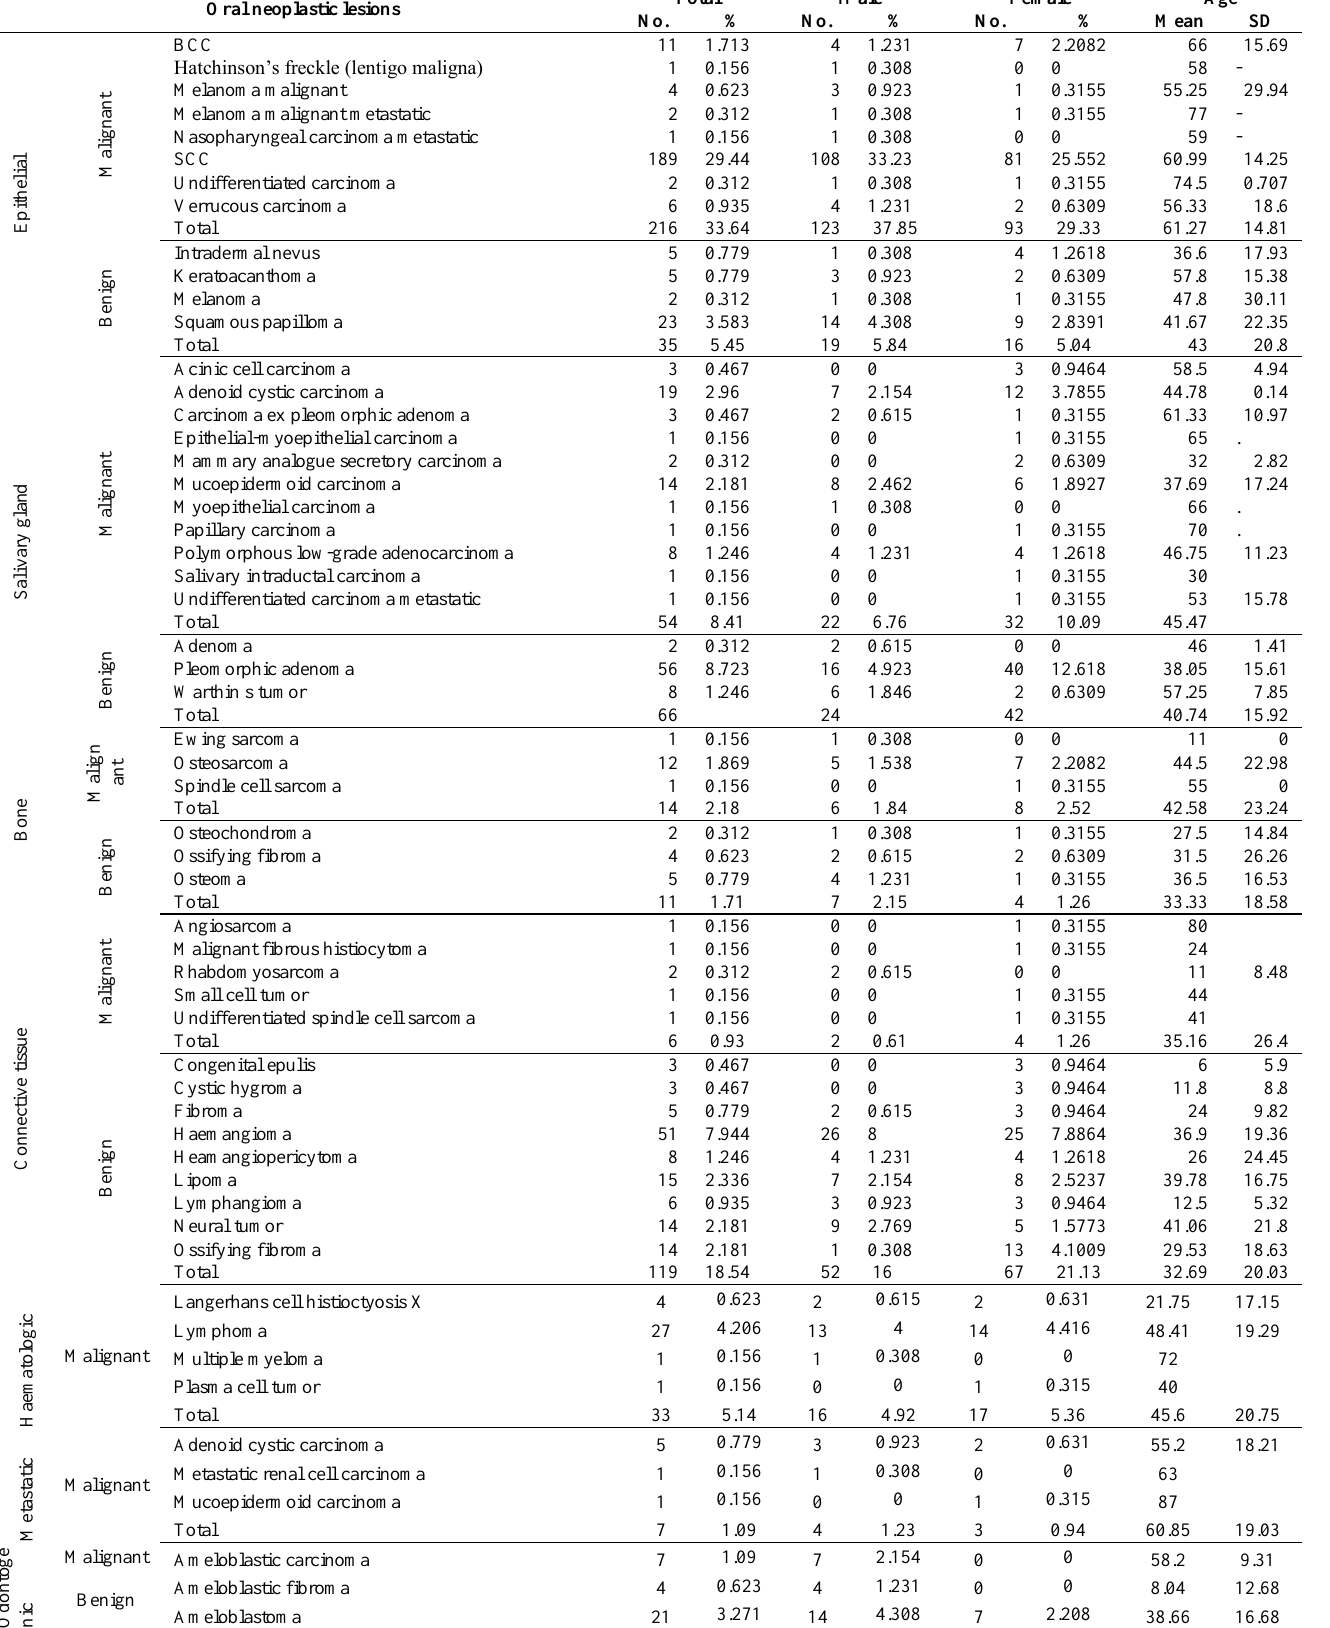
Table 3: Distribution of neoplasms according to the diagnosis concerning gender and mean age Total Male Female Age Oral neoplastic lesions No. % No.